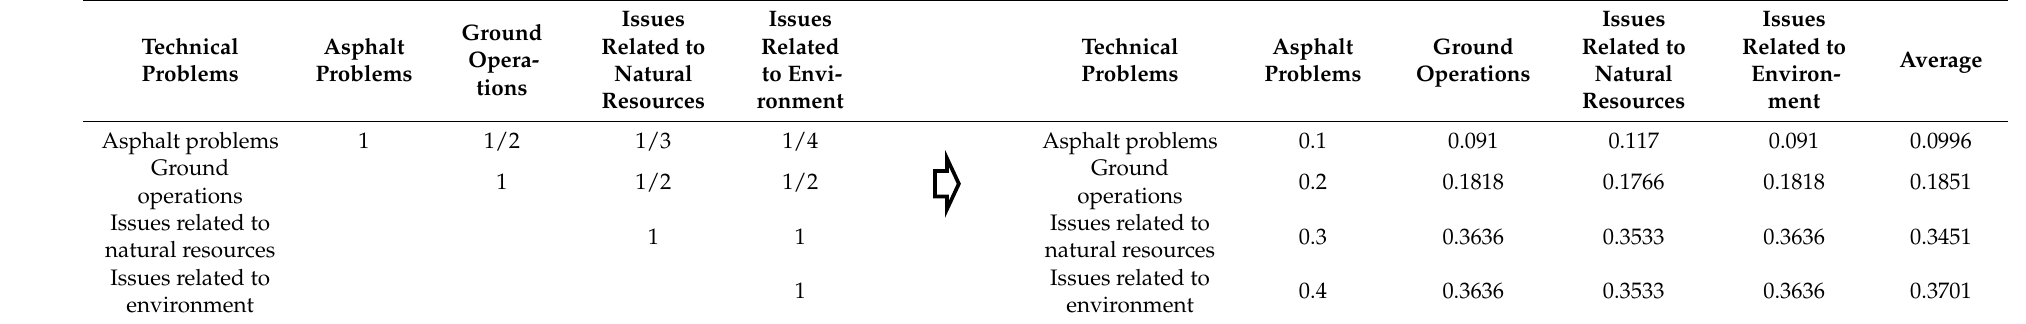
Table 5. The pairwise comparisons matrix for management